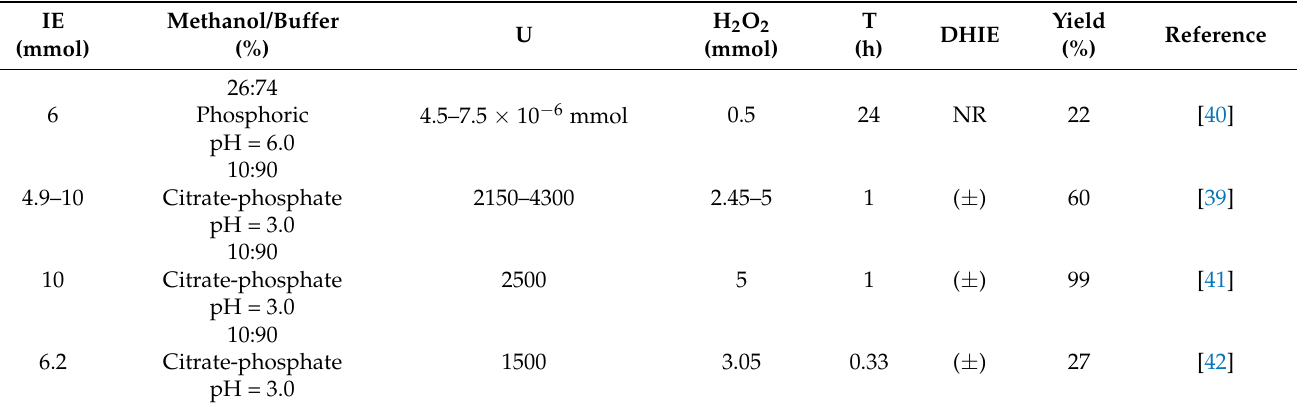
Table 3. Synthesis of DHIE from IE with